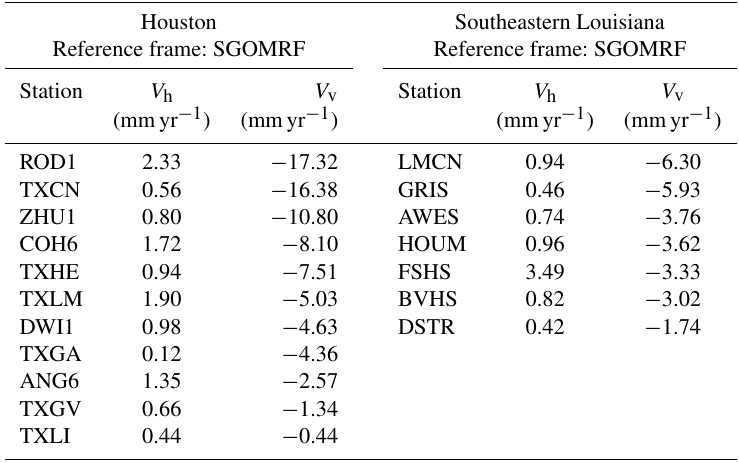
Table 3. Horizontal ( V h ) and vertical velocities ( V v ) of GPS stations plotted in Fig. 9. Houston Southeastern Louisiana